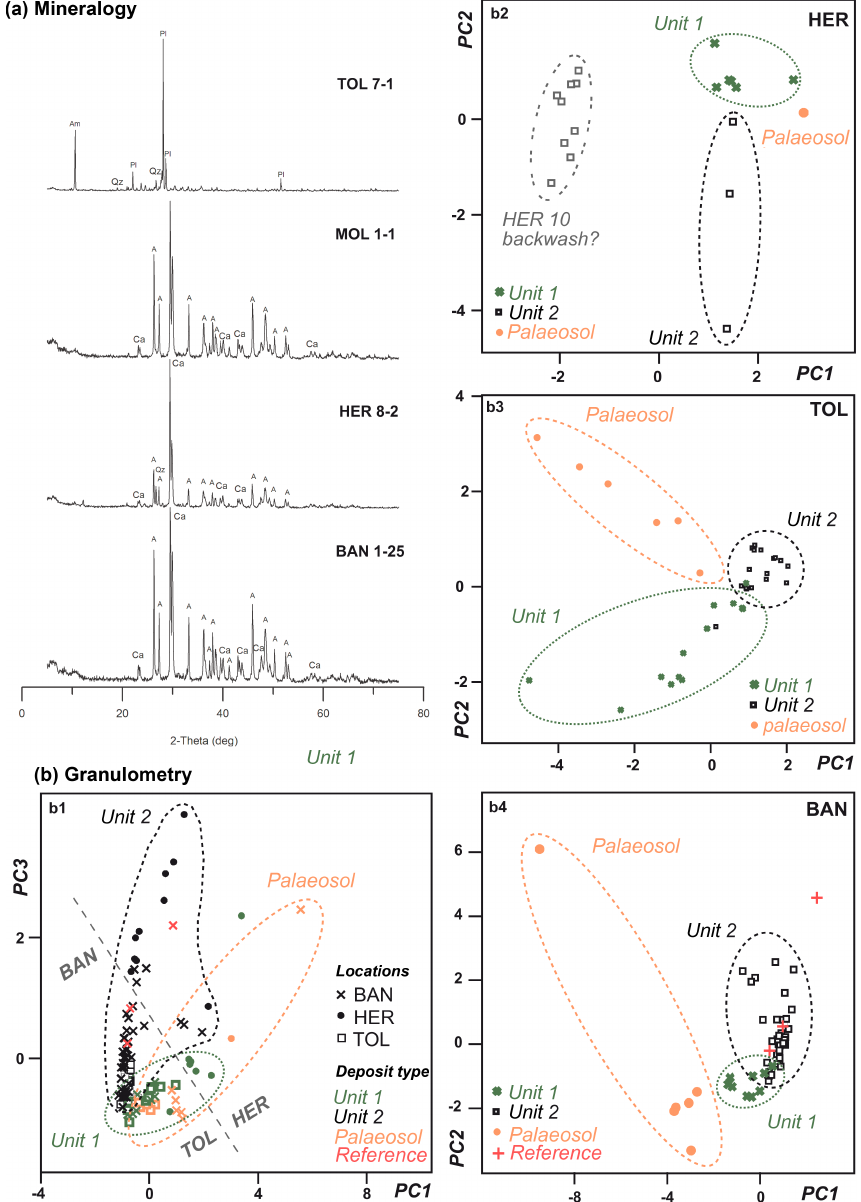
Figure 8. PCA results for sandy deposits of Typhoon Haiyan. (a) XRD studies allow for a separation of deposits from carbonate coasts (MOL, HER, BAN) and the siliciclastic coast (TOL) on the basis of bulk mineralogy. Ca: calcite; A: aragonite; Qz: quartz; Pl: plagioclase; Am: amphibole. (b) Grain-size data reflect both site-specific characteristics (TOL, BAN, HER) and differences in formation (unit 1, unit 2, palaeosol) (b1) . A discrimination of sediment formation (unit 1, unit 2, palaeosol) due to particular clusters is even more pronounced on the intra-site level (b2–b4)